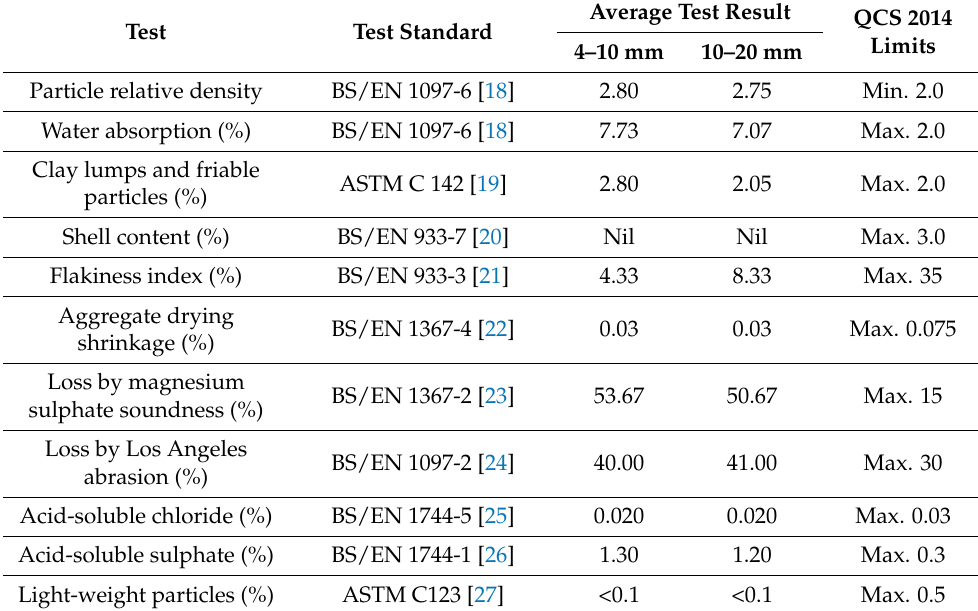
Table 1. Properties of TBM muck as concrete coarse